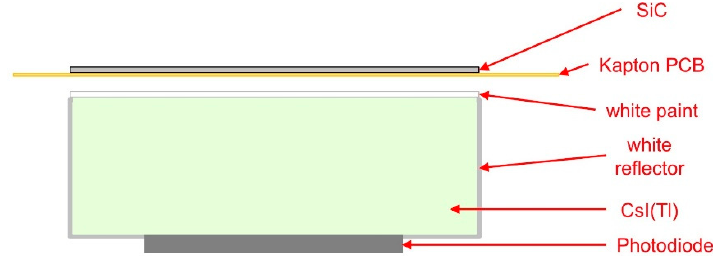
Figure 10. Scheme of the elementary telescope cell of the NUMEN Particle Identification Detector.